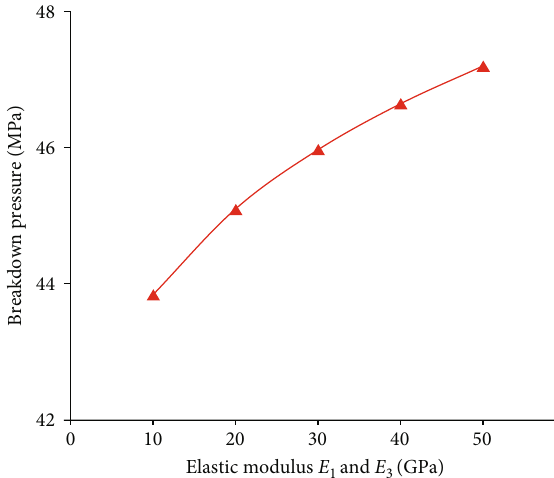
Figure 8: E ff ect of modulus contrast on the breakdown pressure.